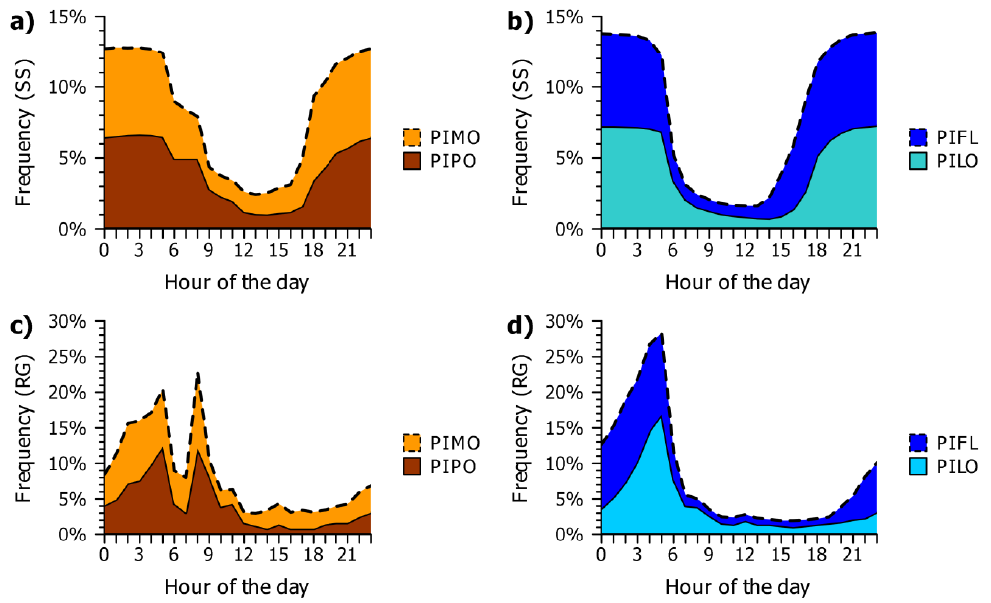
Figure 7. Average daily cycles of stem swelling (SS) and real growth (RG). Graphs ( a ) and ( c ) are for the Sheep Range; graphs ( b ) and ( d ) are for the Snake Range. Species codes are the same as in the Figure 2 caption.